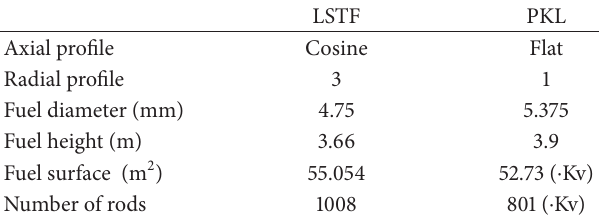
Figure 35: Core exit temperature. Table 8: Core design